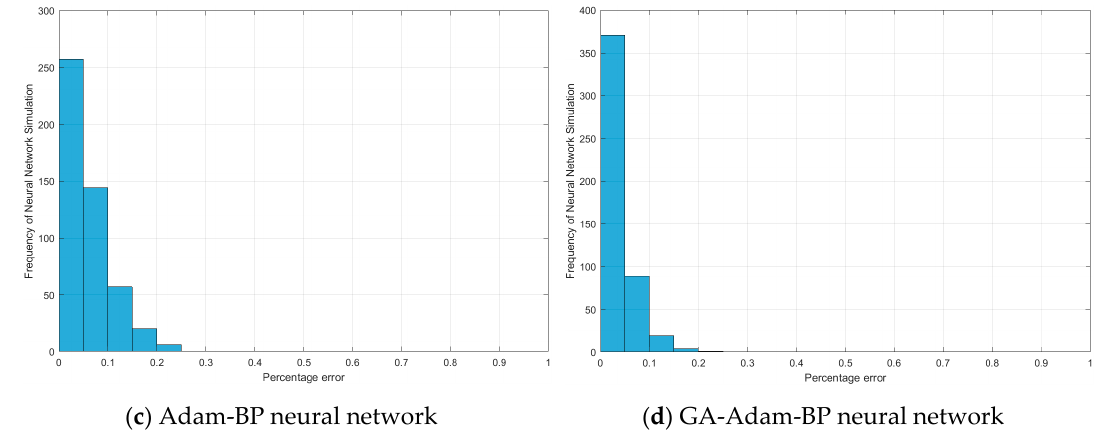
Figure 16. Histogram of percentage of four neural network models.